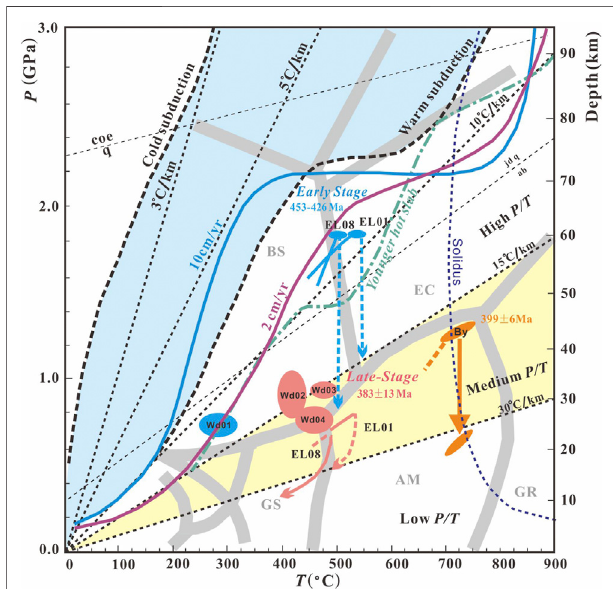
FIGURE 13 | The summarized P – T conditions and paths of the high- pressure rocks in the Ondor Sum Group. Wd01 refer to the P – T results of the blueschist at Wulangou cited from Tang and Yan (1993). Wd02 and Wd03 refer to the P – T results of sodic-amphibolite bearing quartzite (Li et al., 2014b) and barroisite schist (Zhang et al., 2015) at Airgin Sum respectively. Wd04 refer to the P – T result of epidote-blueschist at Naomuhunni (Zhang et al., 2015). By refers to the P – T path of the Barrovian metamorphism the Baoyintu Group in Chen et al. (2015). EL01 and EL08 refer tothe P – Tpaths of HP schists in this study. The bold dotted curves indicate the approximate range of the geothermal gradient at slab surface between cold and hot subduction zones simulated in Syracuse et al. (2010). The thick curves indicate P – T paths predicted for differing convergence velocities of the incoming plate (van Keken et al., 2002, 20 Ma, 30 dip). In general, slower convergencevelocities(2 cm/yr)arepredictedtoresultinhighertemperatures at a given depth compared to faster convergence velocities (van Keken et al., 2002, 10 cm/yr). The thick chain-dotted line refers to a younger slab have highergeothermalgradientsatboththesurfaceasindicatedinWeiandZheng et al. (2020). The reaction ab = jd + q and the transition lines of Al 2 SiO 5 were calculated using THERMOCALC. The division of the metamorphic facies seriesisafter Miyashiro (1961, 1994).The metamorphic faciesboundaries are after Maruyama et al. (1996) and Oh and Liou (1998).